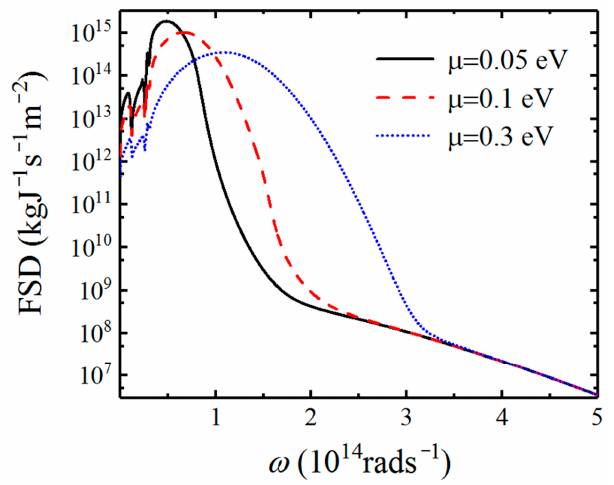
Figure 8. Force spectral densities of graphene-covered Bi 2 Se 3 as a function of angular frequency for different chemical potentials at a fixed distance 𝑑 = 20 nm.